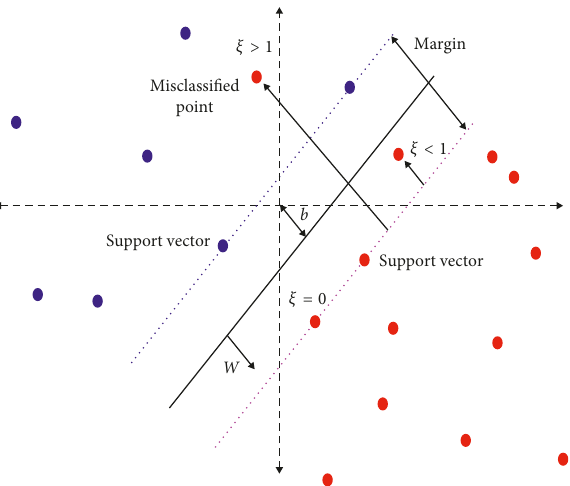
Figure 2: Linear separating hyperplanes for the nonseparable case of SVC by introducing the slack variable ( ξ These slack variables help to find the hyperplane that provides the minimum number of training errors.